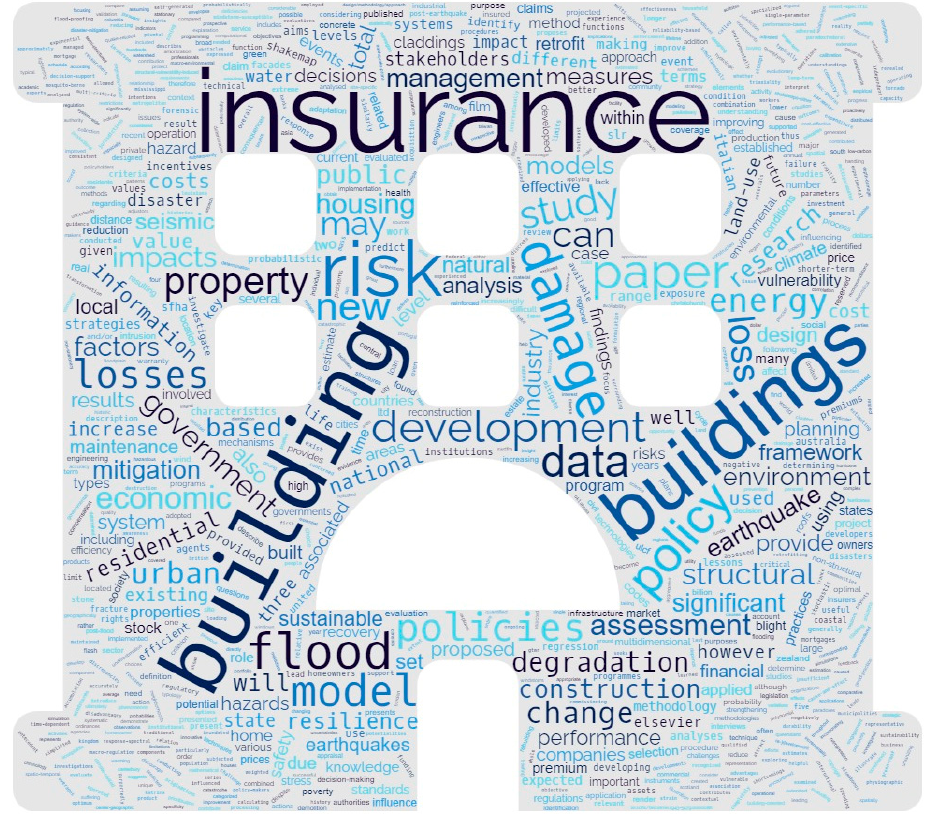
Figure 1. Word cloud of the studies found in Web of Science related to insurance policies in buildings.